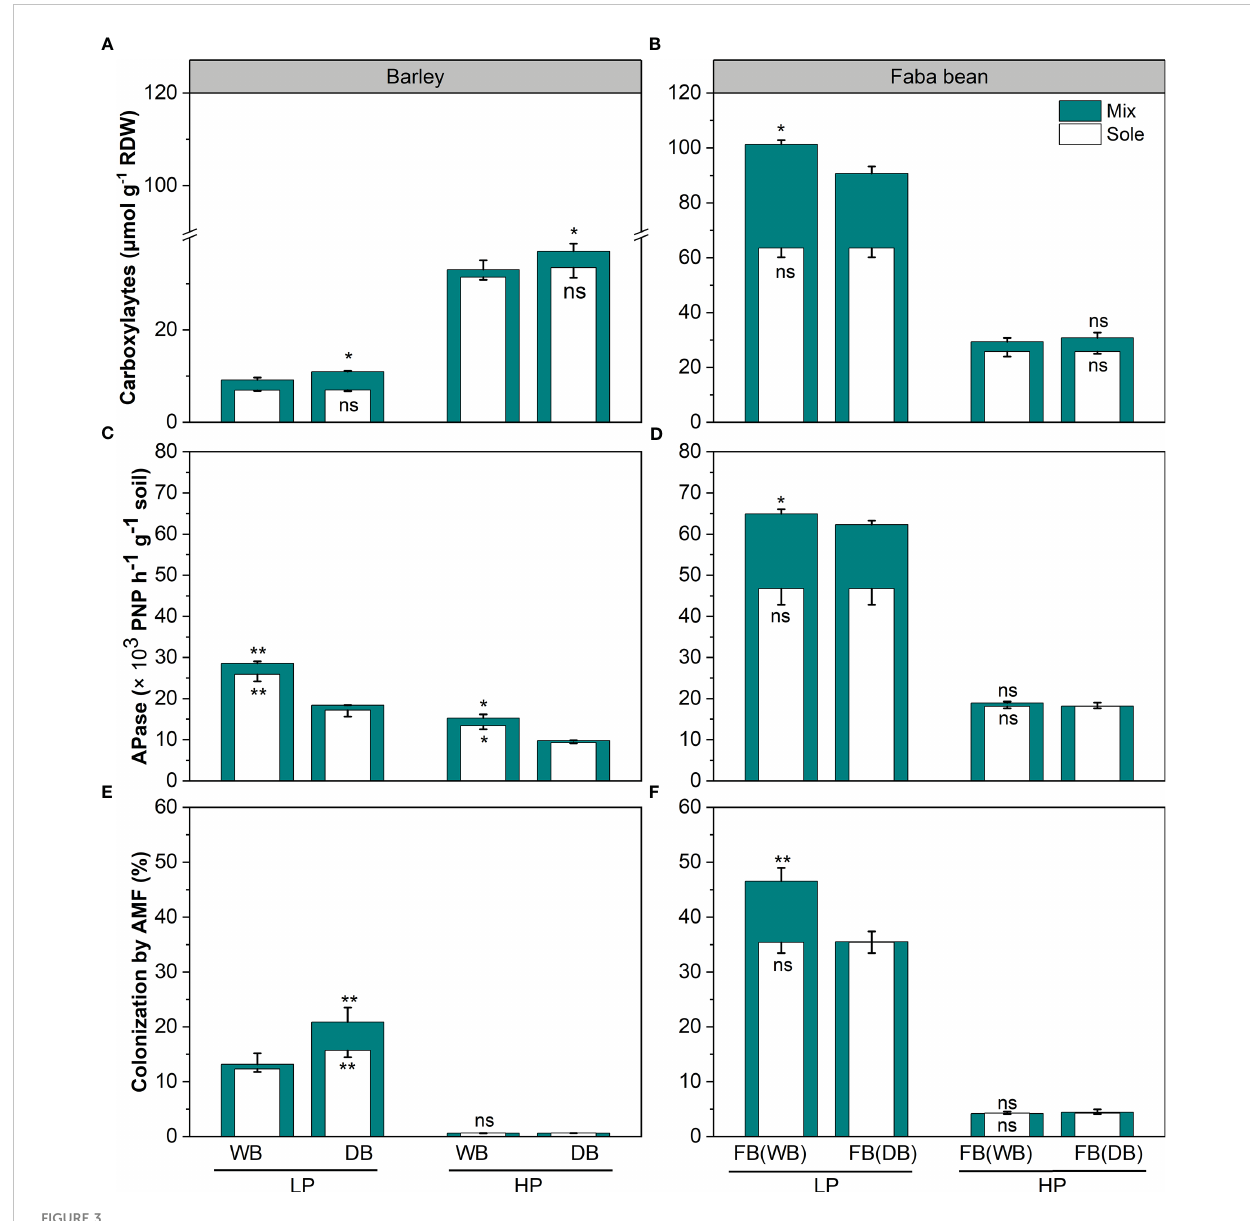
FIGURE 3 The amount of rhizosphere carboxylates per dry weight (A, B) , activity of acid phosphatases (C, D) , and mycorrhizal colonization (MC; E, F ) for barley and faba bean as sole crops and mixtures under contrasting P conditions. The open and closed bars represent plants grown as sole crops and mixtures. Values are the means of three replicates. The error bars represent the standard deviation (SD) of the mean. Within the P treatment, asterisks denote a signi fi cant difference between the wild and domesticated barley or faba bean grown with them (signi fi cant level: *, p < 0.05; **, p < 0.01; ***, p < 0.001; ns, not signi fi cant). FB(WB), faba bean in FB/WB; FB(DB), faba bean in FB/DB; Sole, WB, DB, and FB grown alone; Mix, FB grown with WB and FB grown with